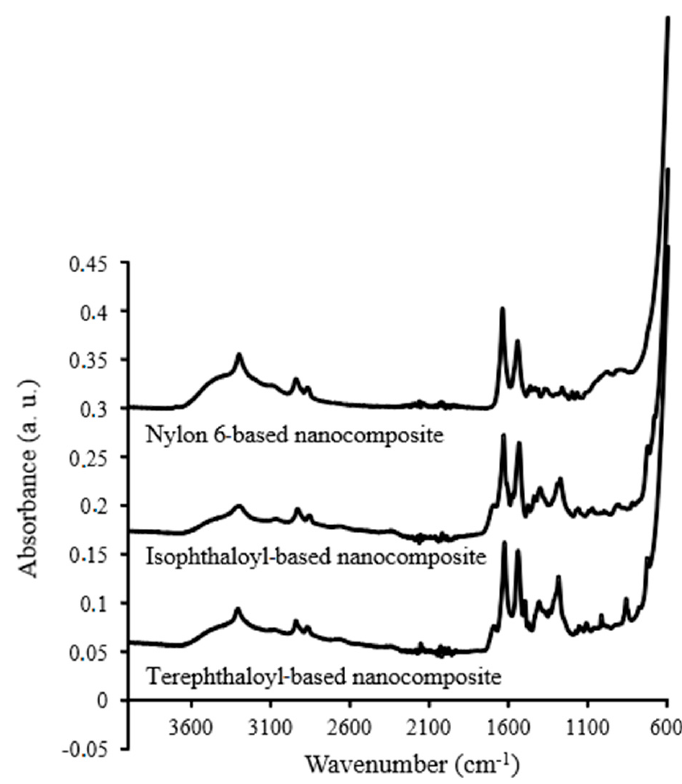
Figure 1. The IR (infrared) spectra of the resulting nanocomposites used in the study. The spectra are normalized to make their comparison easier.